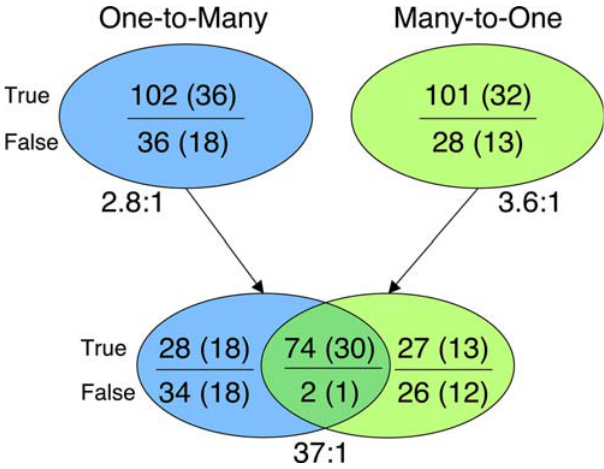
Figure 3. Matches to the PSI Test Set. The number of true and false matches to the PSI test set before and after reciprocal filtering is shown. The top ovals show the number of true and false matches found by each method alone, with the number of query proteins in parenthesis, and the true/false enrichment ratios below. The bottom ovals show the same data with reciprocity imposed, taking the intersection of the matches found by each method.